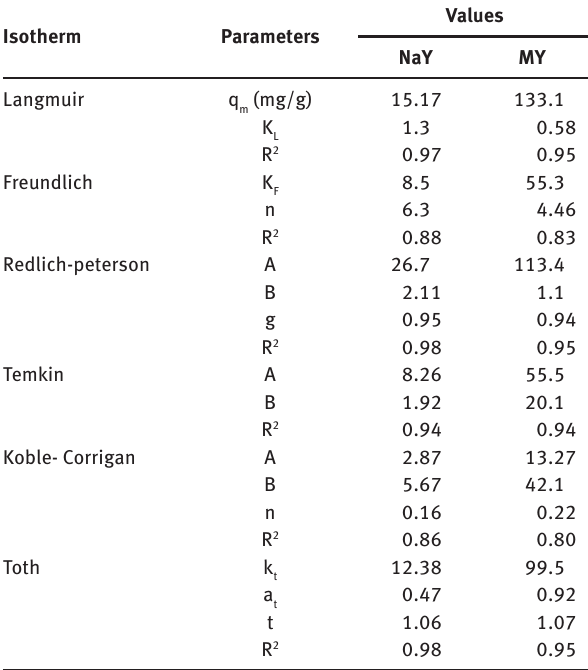
Table 3: Isotherms parameters values for MB adsorption on micro- porous NaY and hierarchical MY.